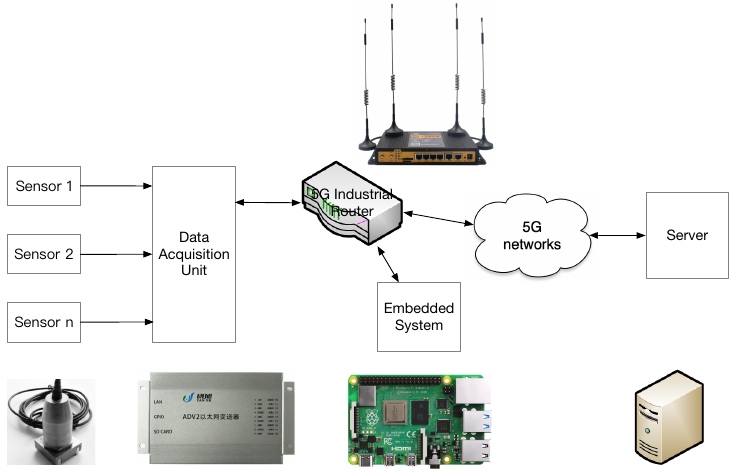
Figure 1. Block diagram of the test platform.